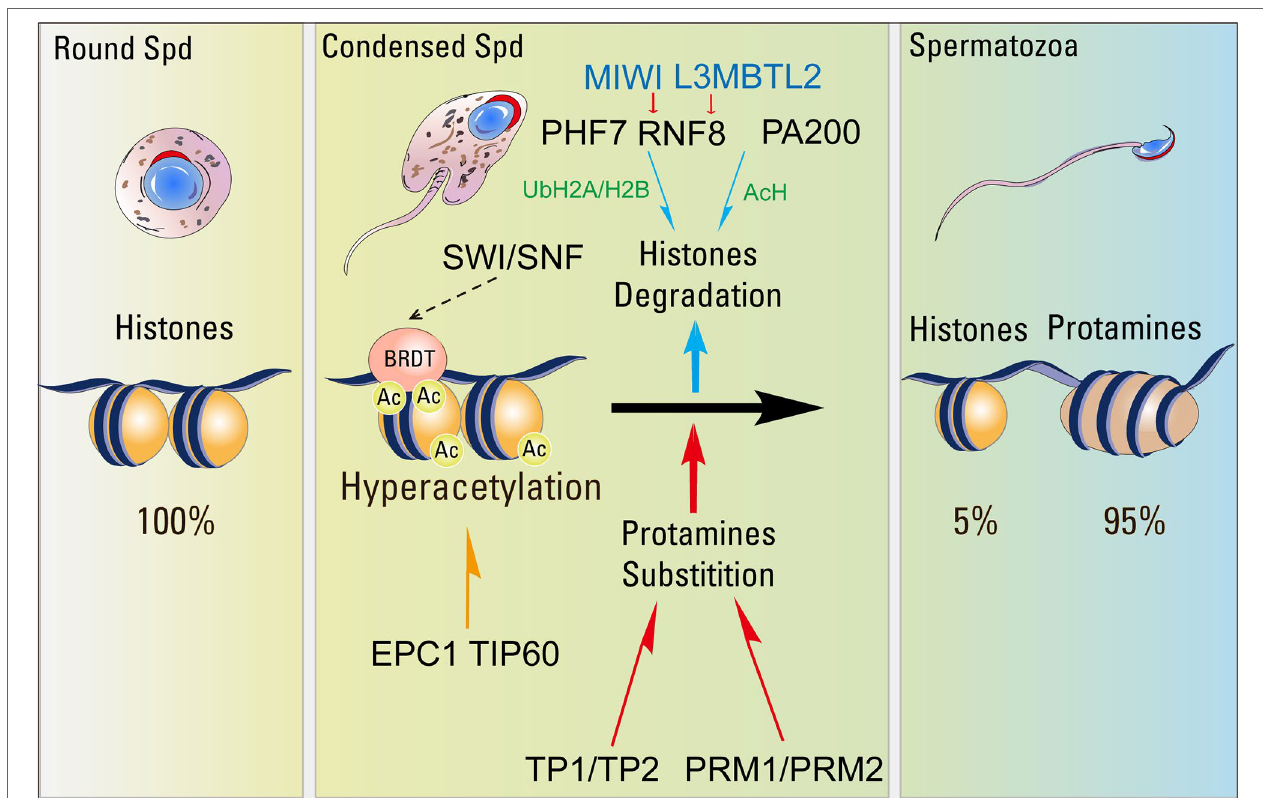
FIGURE 2 | The key factors related to the histone-to-protamine transition. Global incorporation of various H2A, H2B and H3 histone variants creates highly unstable nucleosomes, which then undergo histone hyperacetylation by EPC1/TIP60 or some other nucleosome acetyltransferase complexes. Acetylation at critical lysines further destabilizes the nucleosomes, while tail acetylation generates a platform for the recruitment of BRDT. BRDT interacts with the SWI/SNF family protein then starts the process of histone eviction and replacement by TPs. Evicted acetylated histones would then be recognized by PA200 and degraded by proteasomes during spermatogenesis. RNF8 could catalyze the ubiquitination of H2A. Ubiquitinated H2A and H2B control H4K16ac by regulating the association of MOF to the chromatin and facilitates histone removal in elongating spermatids. MIWI binds to RNF8 in the cytoplasm of early spermatids (Spd) through a Piwi-interacting RNA (piRNA)-independent manner, and promotes the nuclear translocation of RNF8 in late spermatids to catalyze histone ubiquitination and trigger histone removal. L3MBTL2 could interact with RNF8 and facilitate RNF8-dependent histone ubiquitination-related histone removal. PHF7 could recognize the H3K4me3/me2 and catalyze H2A ubiquitination to facilitate histone removal in elongating